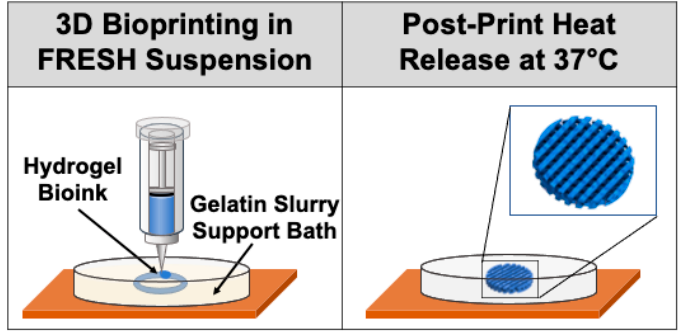
Figure 4. Freeform reversible embedding of suspended hydrogels (FRESH) bioprinting technique. Hydrogel bioink deposited via extrusion bioprinting into a thermoreversible gelatin slurry support bath with a Bingham plastic rheology allows for structural suspension of bioprinted tissue scaffolds to mitigate the force of gravity. An overnight post-print heat release in a 37 ◦ C incubator melts the gelatin, leaving the 3D structure behind.